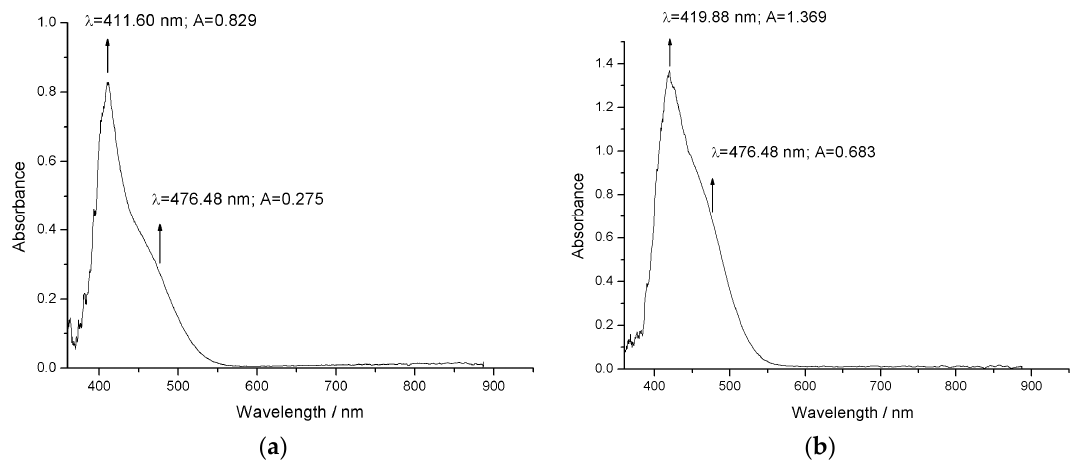
Figure 7. The UV – Vis spectrum of ( a ) BPA and ( b ) BTA. Figure 7. The UV–Vis spectrum of ( a ) BPA and ( b ) BTA. Figure 7. The UV–Vis spectrum of ( a ) BPA and ( b ) BTA.